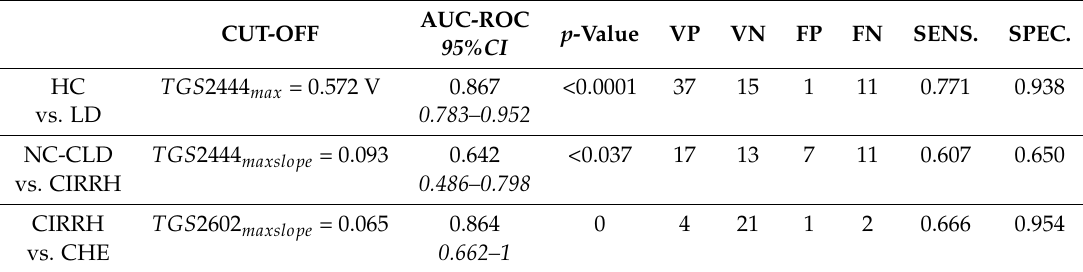
Figure 6. Comparison of receiver operating characteristic (ROC) curves for TGS2444 and TGS2602 output features (maximum output and first derivative) in the total evaluated population (first row, HC versus subjects with liver disease LD), in the population of patients with liver impairment (second row, NC-CLD patients versus CIRRH), in the population of cirrhotic patients (third row, CIRRH versus CHE). Table 3. The cut-off sensor features which permitted to discriminate between HC versus liver disease (LD); in the population of patients with liver impairment, CIRRH versus NC-CLD; in the population of cirrhotic patients, CHE versus